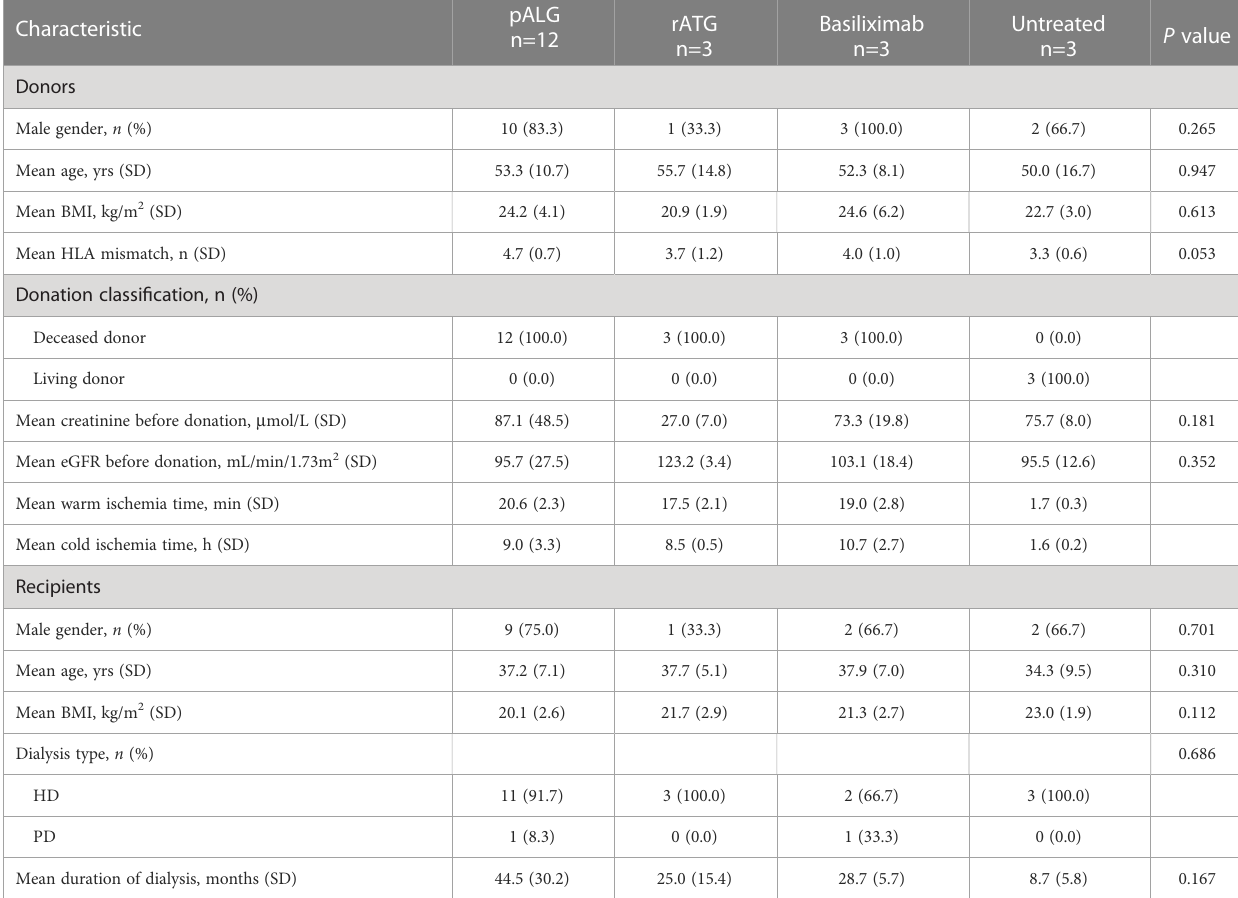
TABLE 1 Demographic characteristics of donors and